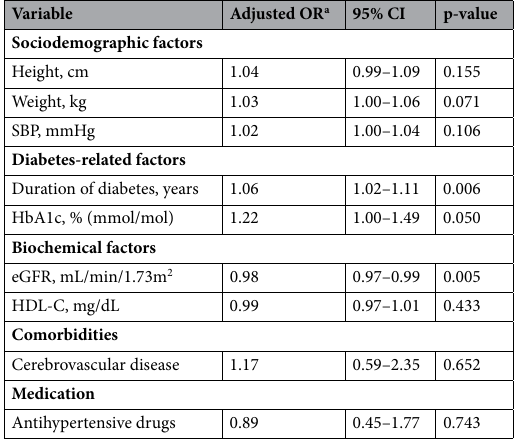
Table 3. Odds ratios and 95% confidence intervals for the relationship between eGFR and future DPN. OR odds ratio, CI confidence interval, SBP systolic blood pressure, HbA1c glycated hemoglobin, eGFR